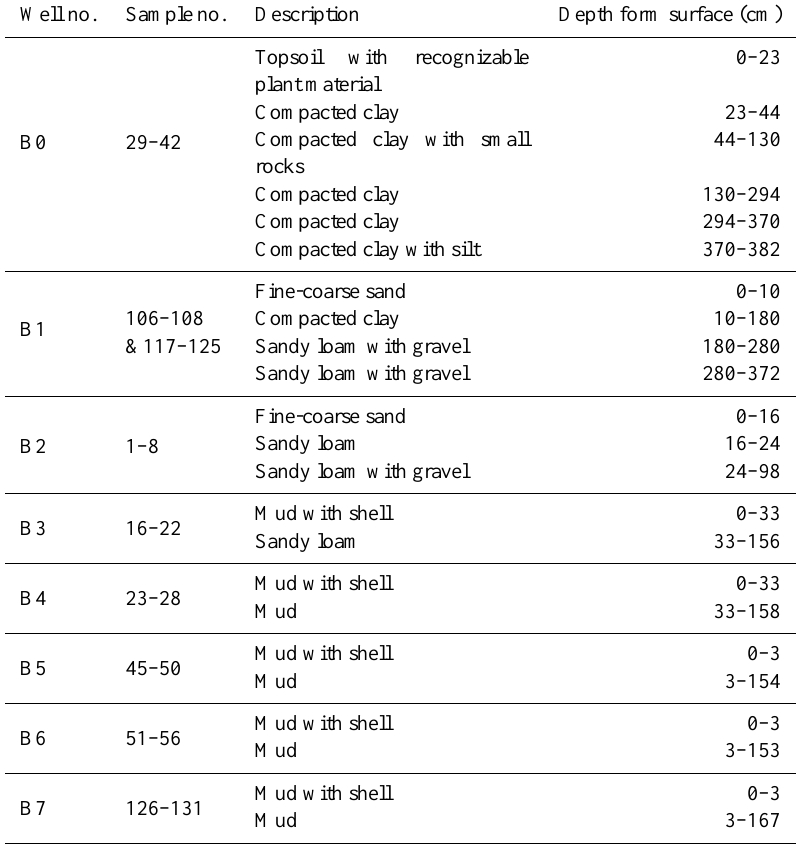
Table 4. Soil characteristics along bald beach transect B-B 0